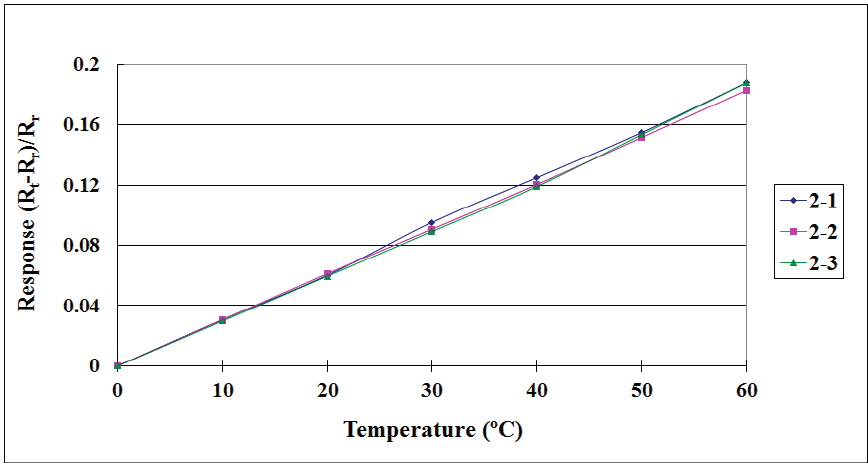
Figure 6. Correction curve of a temperature microsensor (sensor